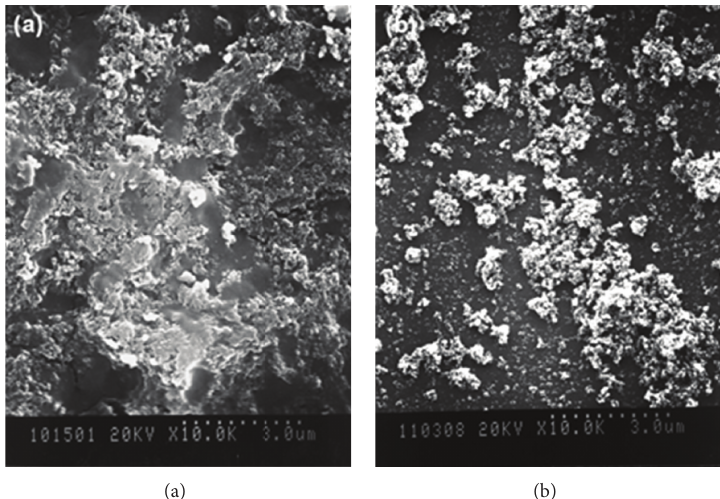
Figure 7: Surface of the UF membrane after ultrafiltration (5KD, magnified 10000x), (a) without TiO 2 and (b) with 10wt% TiO 2 .